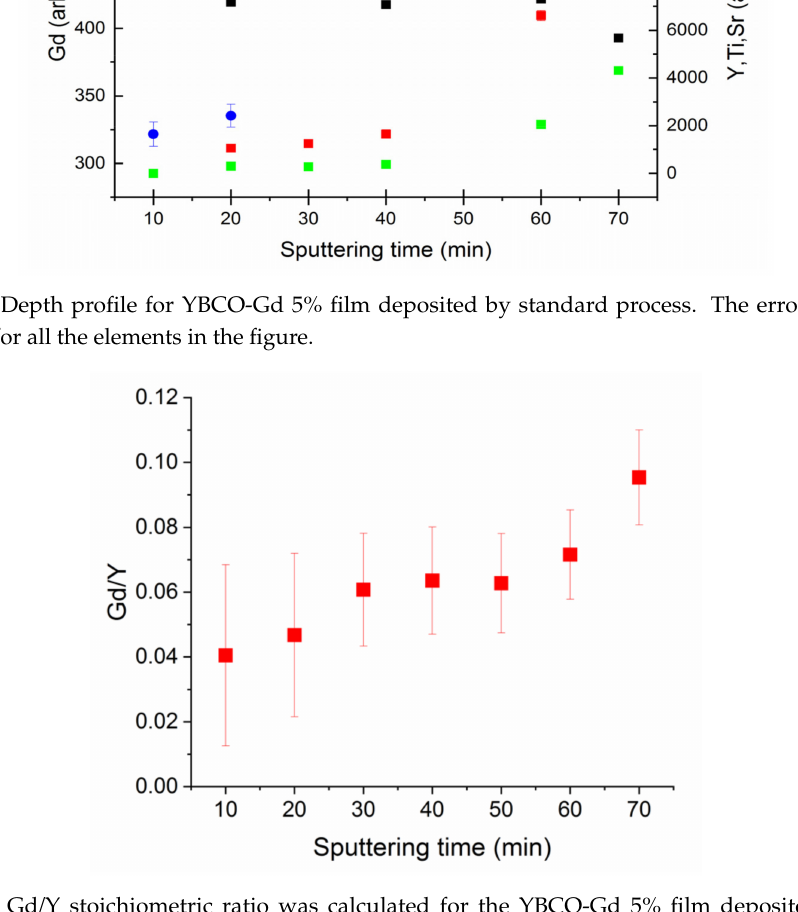
Figure 3. Gd / Y stoichiometric ratio was calculated for the YBCO-Gd 5% film deposited by the standard